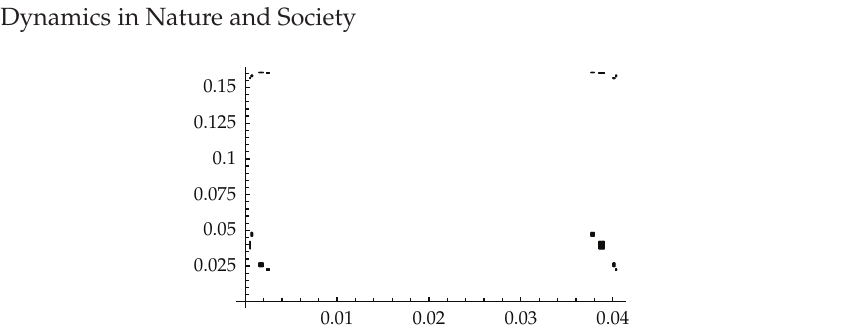
Figure 5: We show, for a (cid:6) 6 . 1872, an attractor of type A3. It consists of 16 periodic rectangles, each of them being transitive under the iteration of the two dimensional map F 16